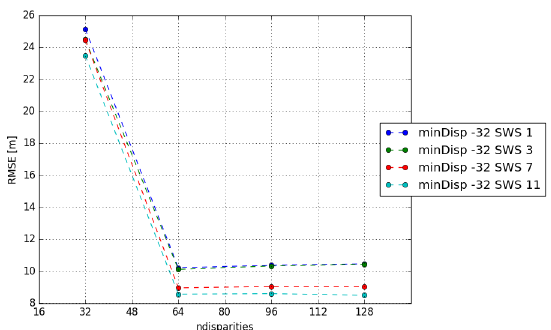
Figure 6: RMSE variation with respect to ndisparities and SAD- WindowSize (minimumDisp = -32, whole tile)